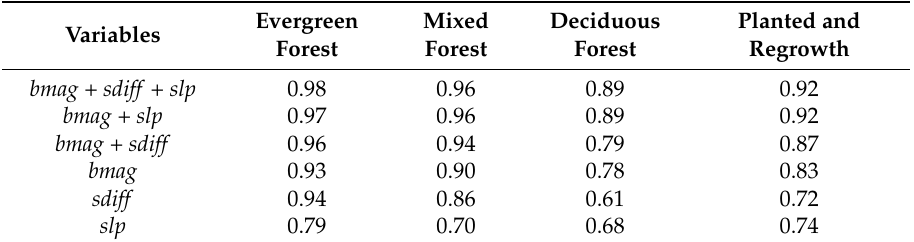
Table 1. Area under curve (AUC) estimates for regression models using different parameters and combinations of parameters, by forest type. AUCs for all models are derived using receiver operating characteristic (ROC) curves presented in Figure 4.